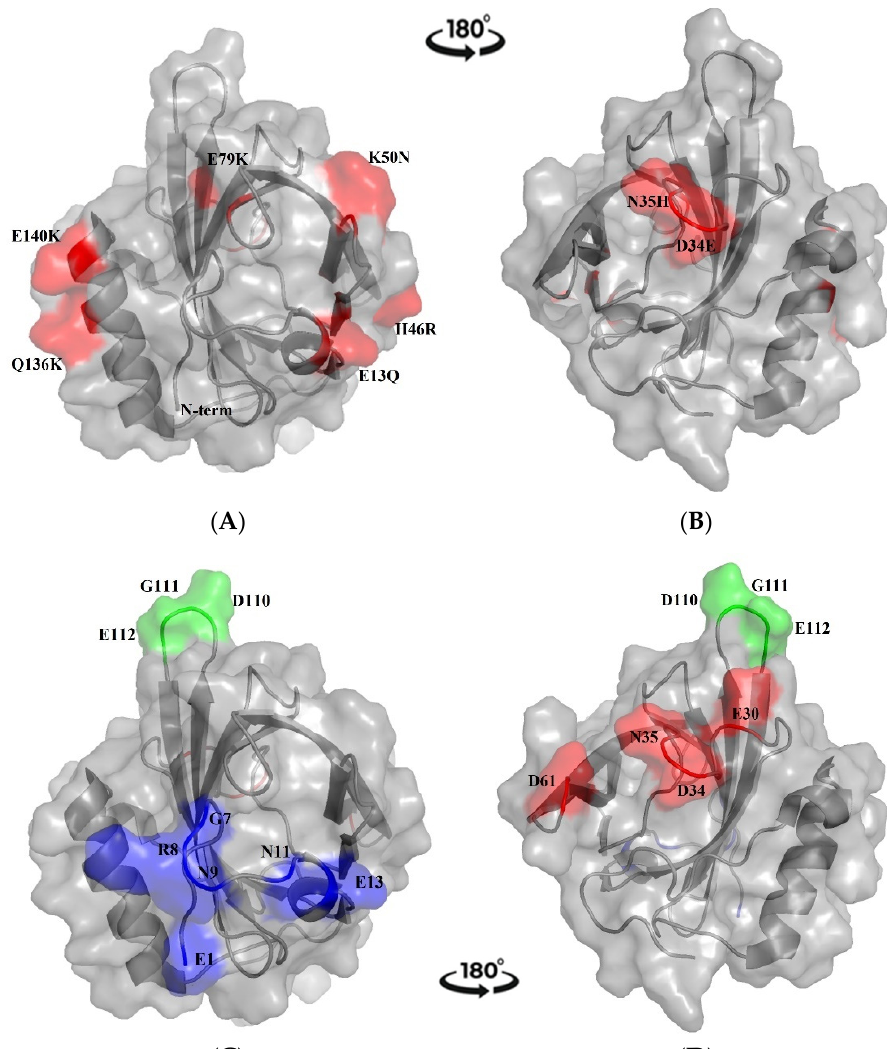
Figure 1. Three-dimensional structure views of the rMus m 1.0102 allergen (PDB code 1df3, model 1): ( A , C ) bottom view of the central cavity, ( B , D ) top view of the cavity, generated by a 180° turn. ( A , B ) Surface and cartoon representations of the rMus m 1.0102 structure. The amino acid substitutions observed in central MUP isoforms correspond to surface-exposed residues of rMus m 1.0102 (red). ( C , D ) Coloured residues of surface and cartoon representations of rMus m 1.0102 solution structure correspond to the three B-cell epitopes predicted by Discotope 2.0 (epitope I in blue, epitope II in red, and epitope III in green).